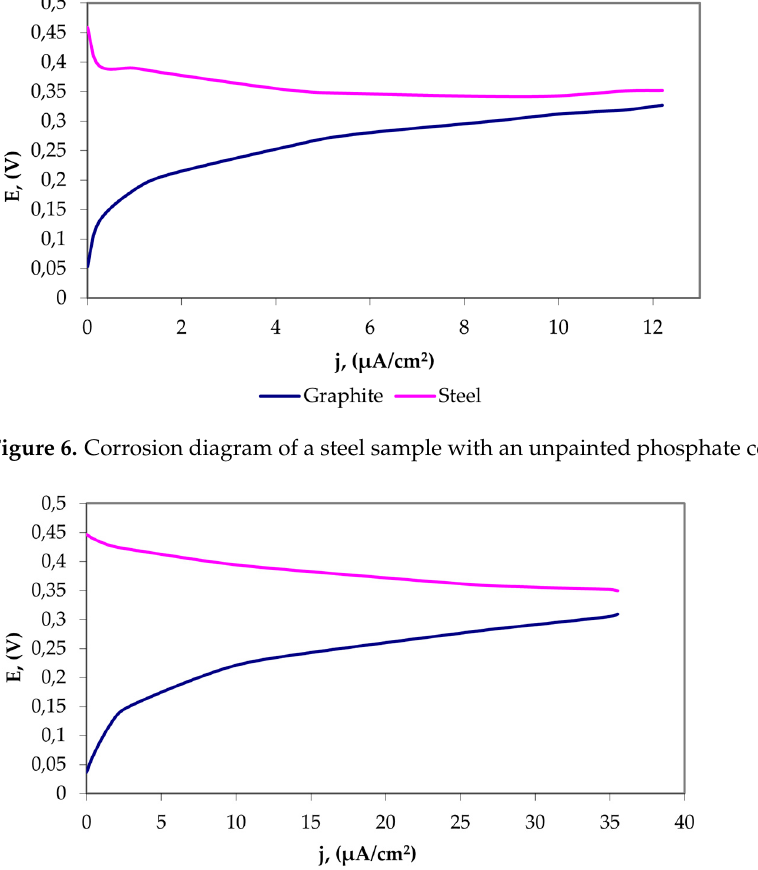
Figure 5. Corrosion diagram of a steel sample without protective coating.